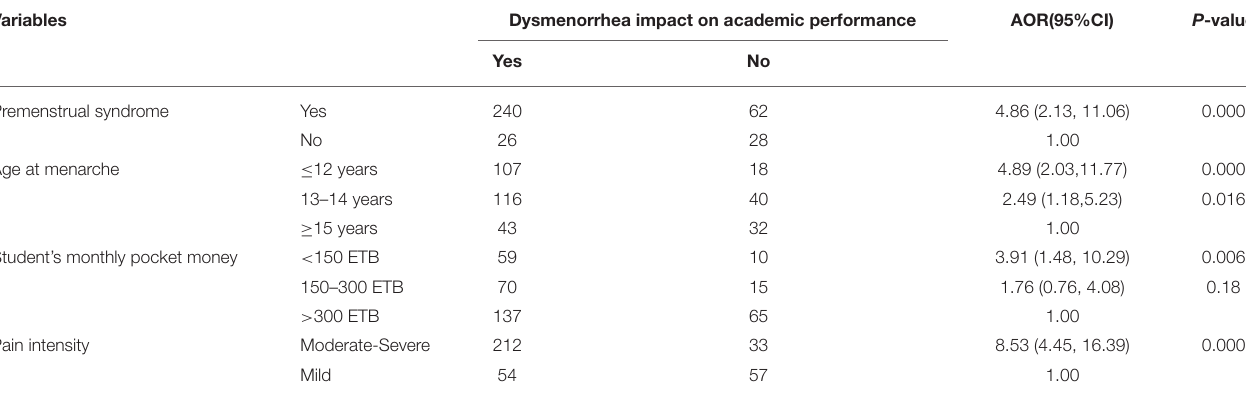
TABLE 5 | Multivariable analysis of factors associated with the impact of dysmenorrhea on academic performance among female undergraduate students, at Haramaya University, Ethiopia, 2020.